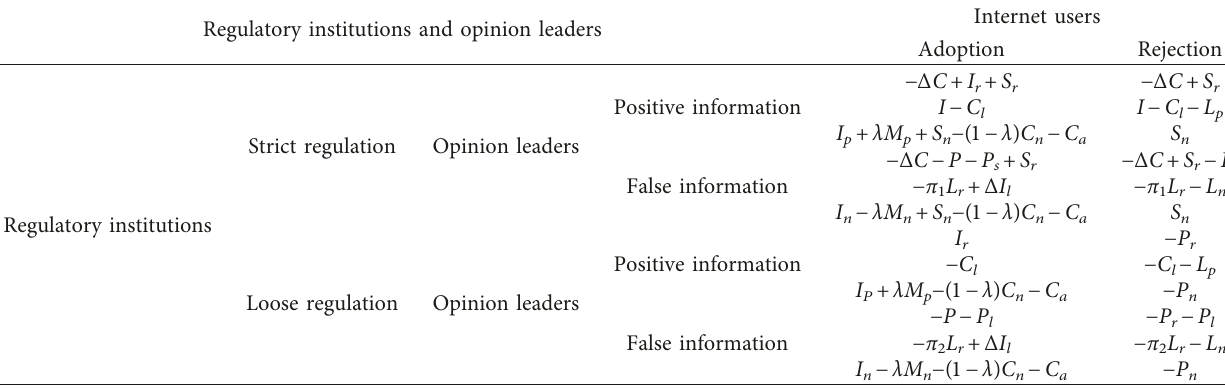
Table 2: The tripartite game income matrix for regulatory institutions, opinion leaders, and Internet users.